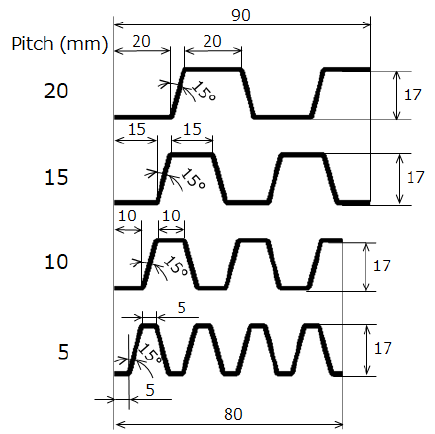
Figure 6. Cross-section of corrugate structure.